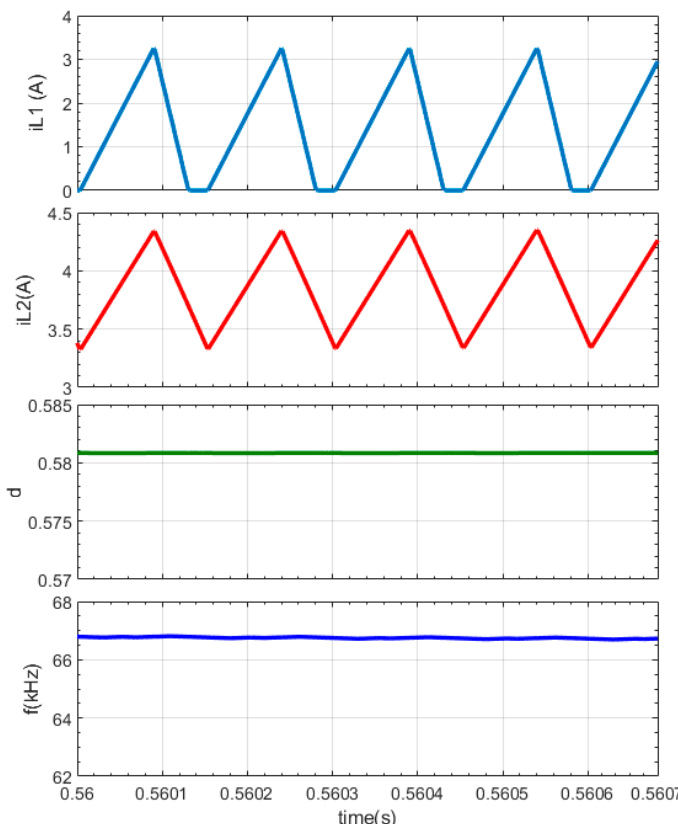
Figure 11. Simulation results for the conversion circuit based on a single switch S’ 1 (Figure 5, bottom). From top to bottom: i L 1 , i L 2 , D and f .